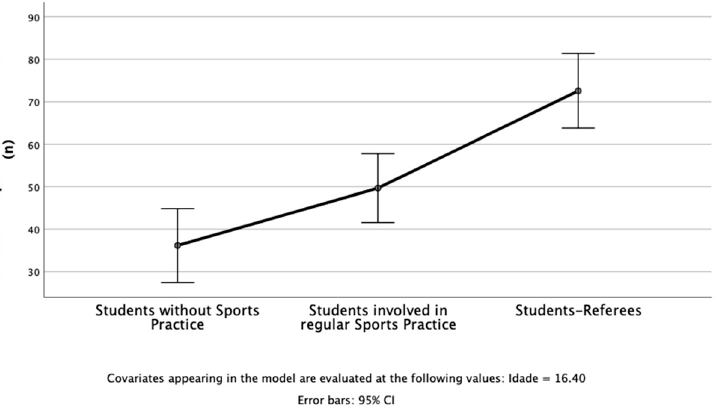
Figure 1. Students without sports practice, students involved in regular sports practice, and student referees in the number of laps in a 20 m shu tt le run.